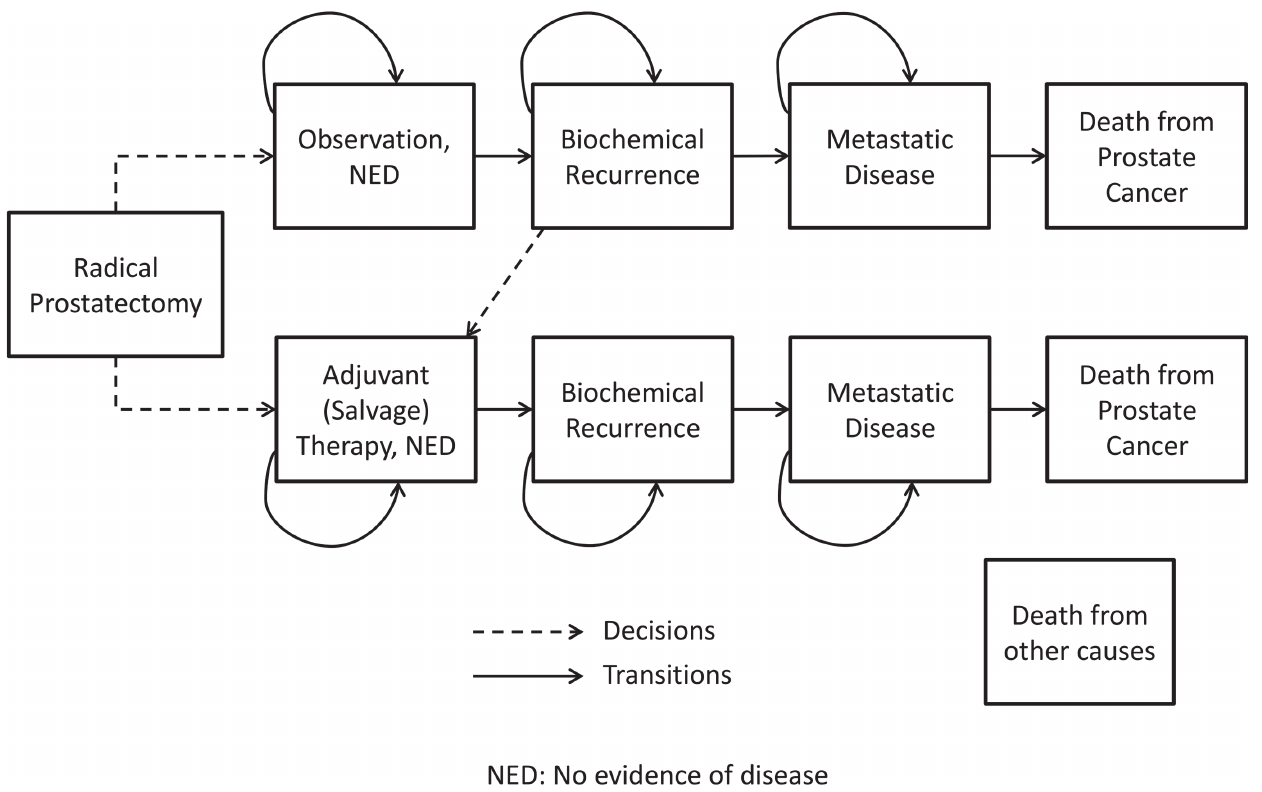
Fig 1. Simplified state transition diagram representing the treatment decisions and health state transitions post radical prostatectomy. NED represents patients with no evidence of disease.